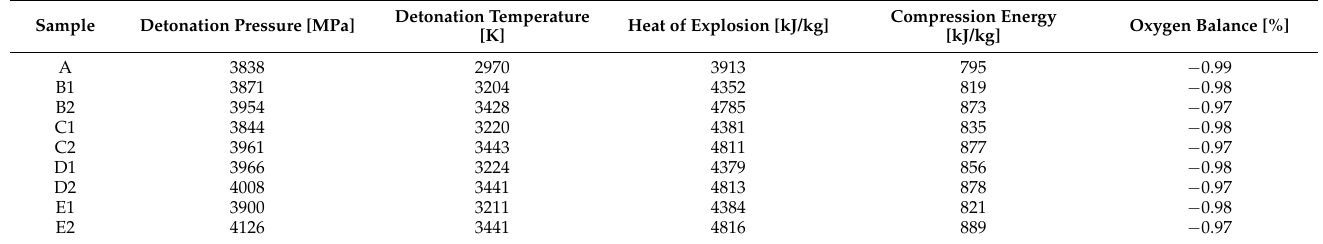
Table 3. Calculated properties of non-ideal ANFO with the addition of variously modified zeolite